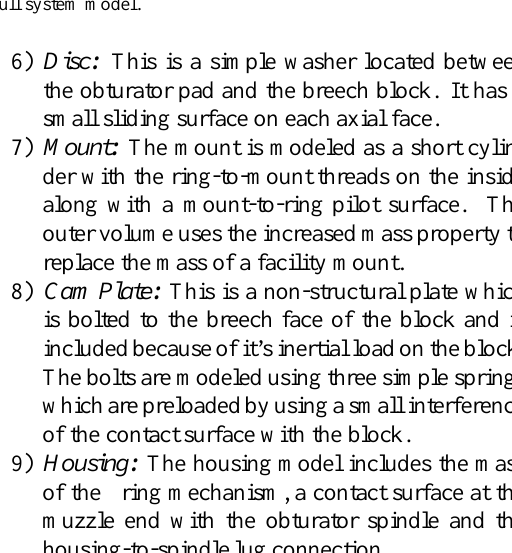
Fig. 1. Cross section of the full system